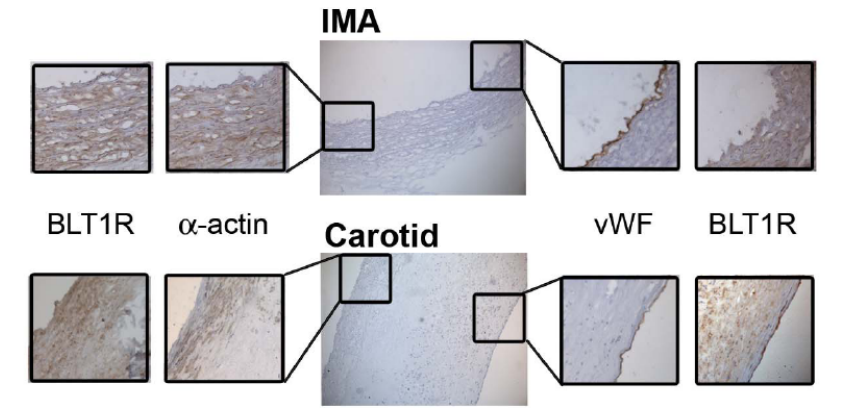
FIGURE 2. Immunoperoxidase staining for the BLT 1 receptor (BLT1R) in human internal mammary artery (IMA, top panels) and atherosclerotic carotid endarterectomy (bottom panels). BLT 1 receptor expression colocalized with α smooth muscle actin in both vessels, and with endothelial von Willebrand factor (vWf) exclusively in atherosclerotic lesions. Adapted from Bäck et